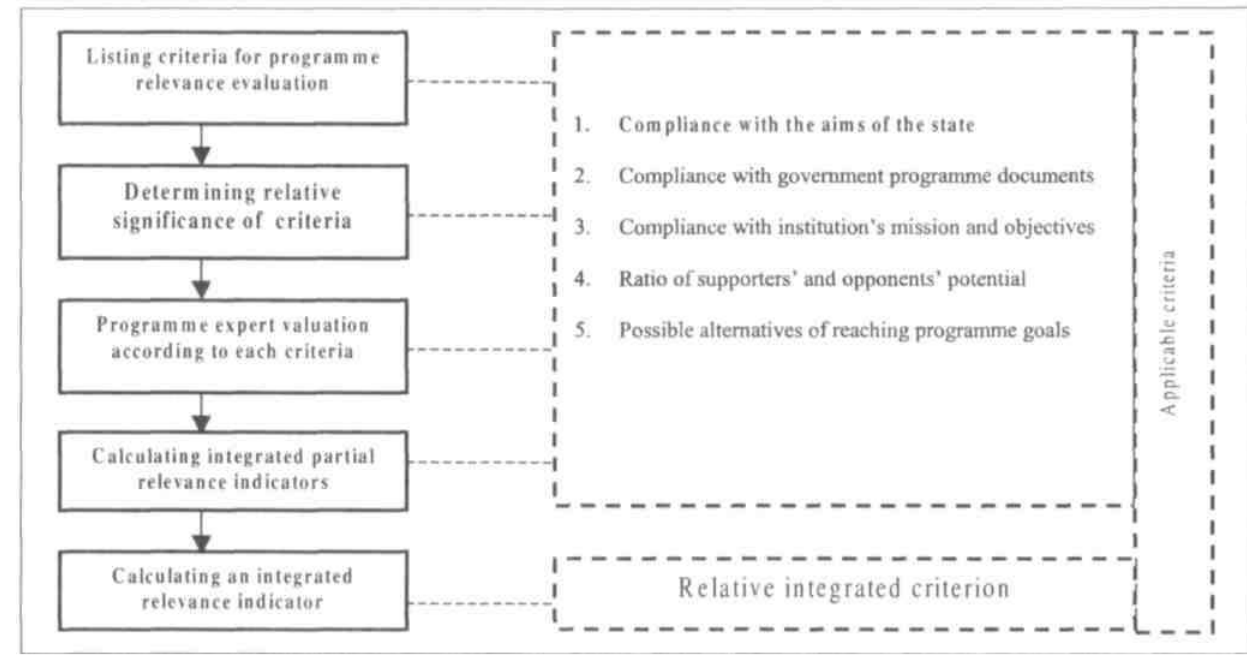
Fig 2. Scheme of programme relevance